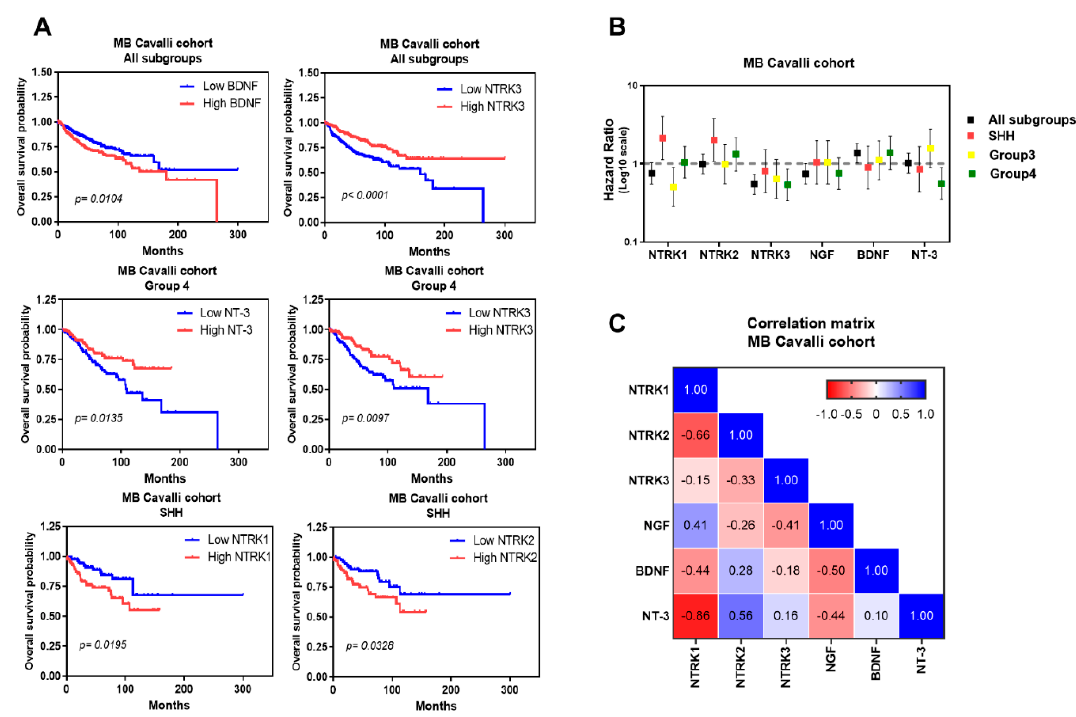
Figure 5. Prognostic value of neurotrophins and their receptors in MB patients. Kaplan–Meier overall survival curve from MB patients according to the expression level neurotrophins and their receptors ( A ). Kaplan–Meier plot of MB overall survival stratified by the median of expression for each marker in the Cavalli cohort [15] are classified into low or high expression levels. The statistical significance was determined using a log-rank test ( p ≤ 0.05). Log of Hazard Ratios of NTRKs and neurotrophins ( B ). Markers with a hazard ratio smaller than 1.00 represent “protective markers” and those with hazard ratios larger than 1.00 represent “risk markers”. ( C ). Heatmap of the correlation matrix of the NTRKs and neurotrophins in all molecular subgroups from the cohort. The correlation coefficient is colour-coded from red ( − 1) representing a negative correlation to blue (1) representing a positive correlation. Sample characteristics and general methods for expression profiling analyses were as described in the legend for Figure 3. Table 2. Differences between high and low gene expression levels of neurotrophins and their receptors and their respective Hazard Ratio values across the 4 MB molecular variants in tumors from patients from the Cavalli cohort [15].